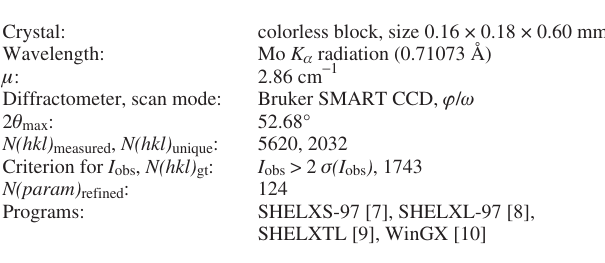
Table 1. Data collection and handling.